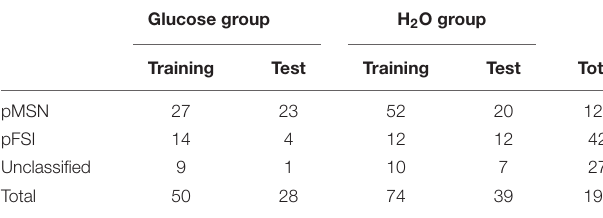
TABLE 1 | Number of neurons recorded in this study.